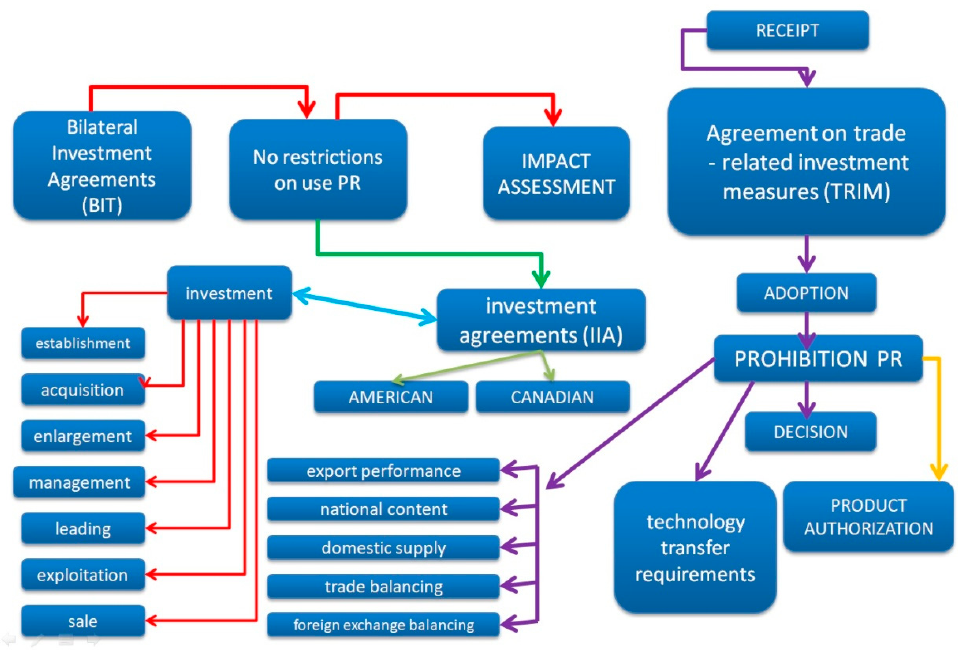
Figure 20. Assumptions of the typology of differences and prohibitions according to the policy. Source: own study.